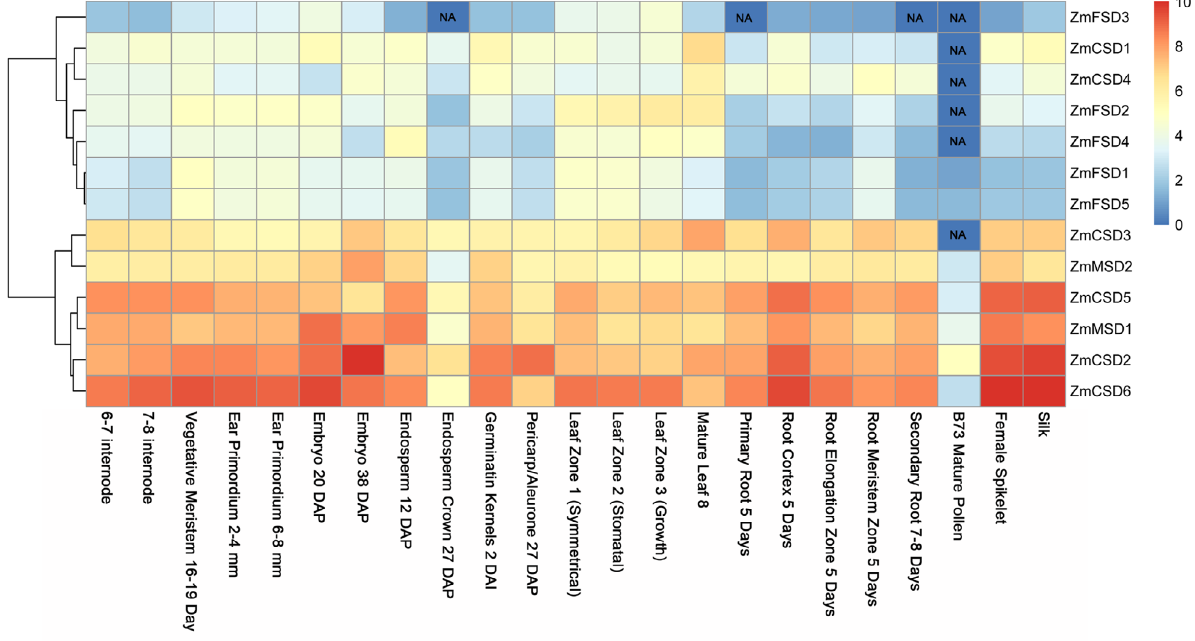
Figure 7 ‒ Expression pattern analysis of the ZmSOD genes in different tissues and organs using transcript data. Expression patterns of the 13 ZmSODs were investigated in 23 different tissues and organs using publicly transcriptome data. FPKM showed “NA” (not available) was replaced by FPKM = 0, and all FPKM values were transformed into log (FPKM+1) to create the 2